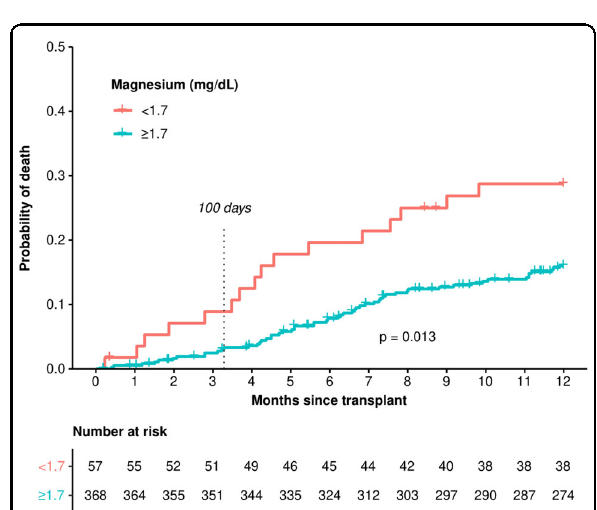
Fig. 3 Overall survival of patients with diffuse large B-cell lymphoma undergoing autologous stem cell transplant by premyeloablative serum magnesium level between 2010 and 2020. Log-rank test p =